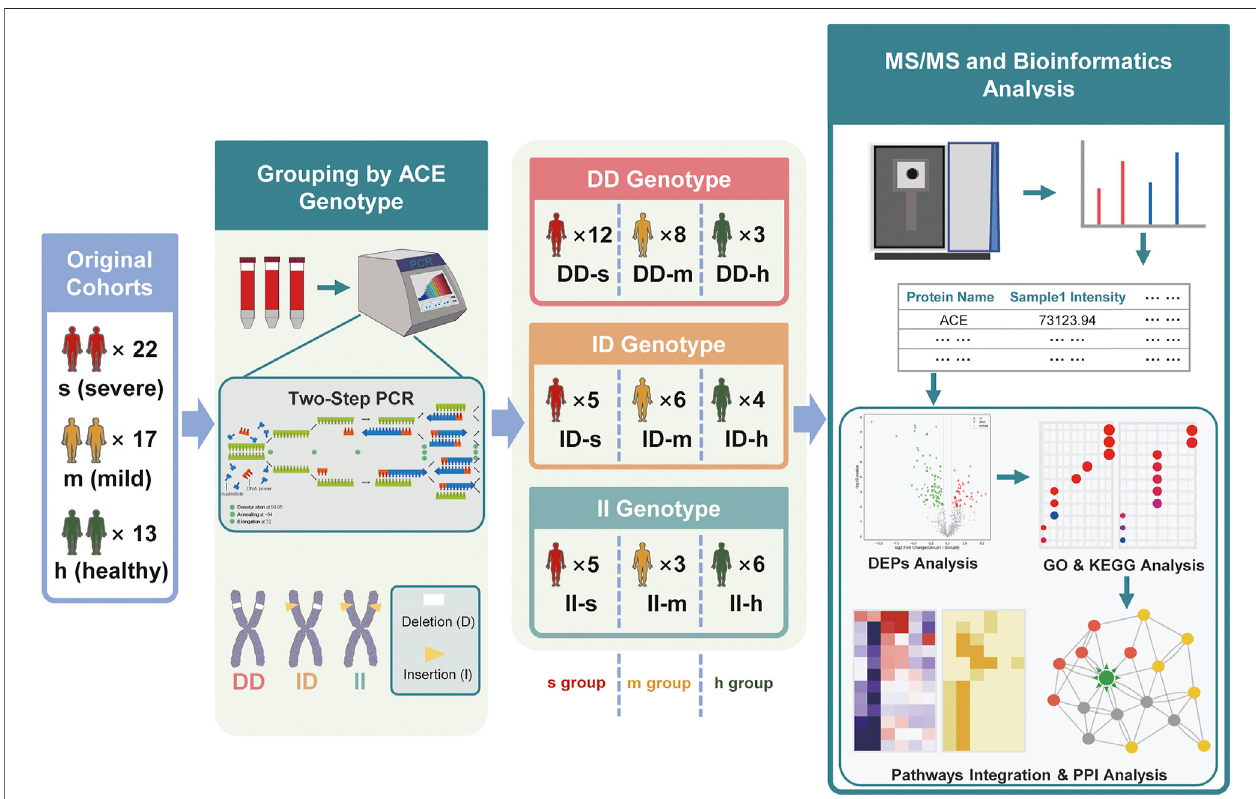
FIGURE 4 | Genotyping, grouping, and proteomic analysis of prospective plasma samples. The original cohorts included 22 s (severe) samples, 17 m (mild) samples, and 13 h (healthy) samples. Each sample ’ s genotype was identi fi ed by the detection of the absorbance after two-step PCR. Then mass spectrometry, identi fi cation, and quantitation were adopted to analyze all the samples, followed by the bioinformatics analysis, including the DEP analysis, enrichment analysis (GO), pathway analysis (KEGG), and PPI analysis. Through multi-pathways integration and PPI analysis, biomarkers of DD genotype expression (ACE high expression) were